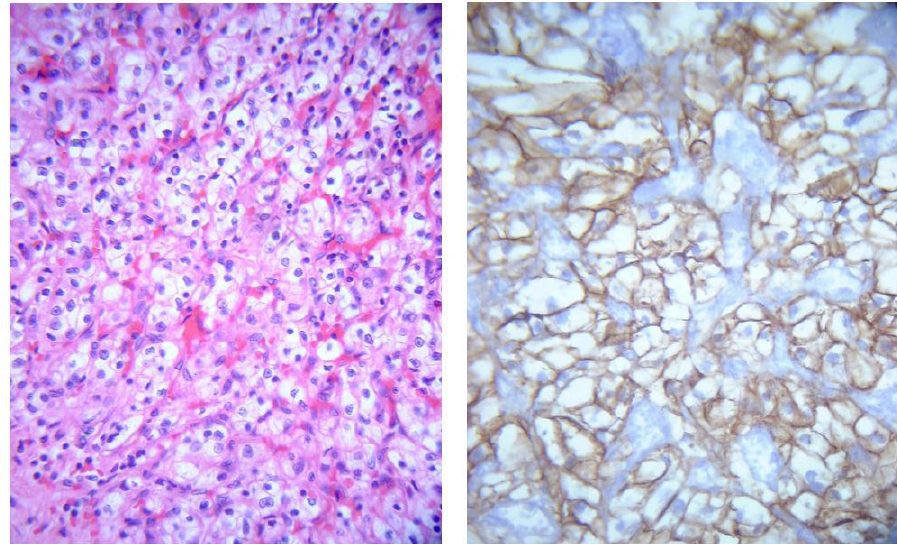
Figure 3. Metastatic RCC. Left, Metastatic renal cell carcinoma to brain resembling hemangioblastoma, H&E stain; right, immunohistochemistry for EMA shows characteristic membranous